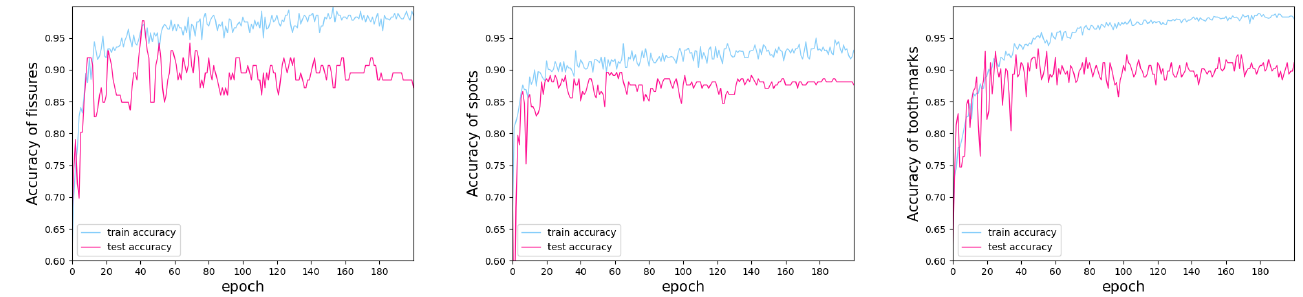
Figure 12. The accuracy change curve for MobileNetV3Large for different